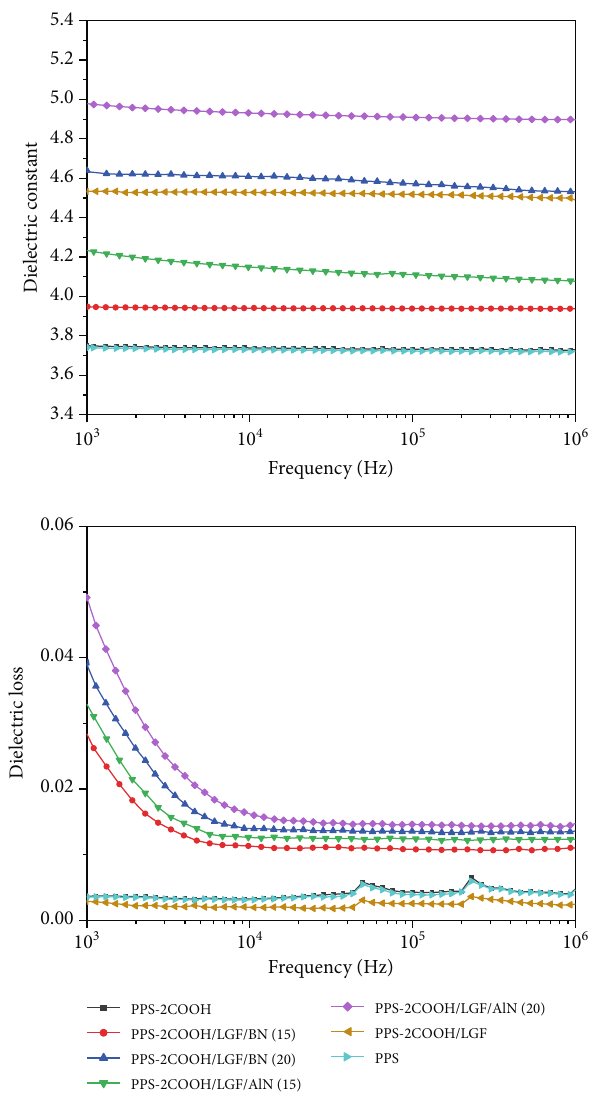
Figure 8: E ff ect of ceramic fi ller content on the ε and tan δ value of composites at a di ff erent